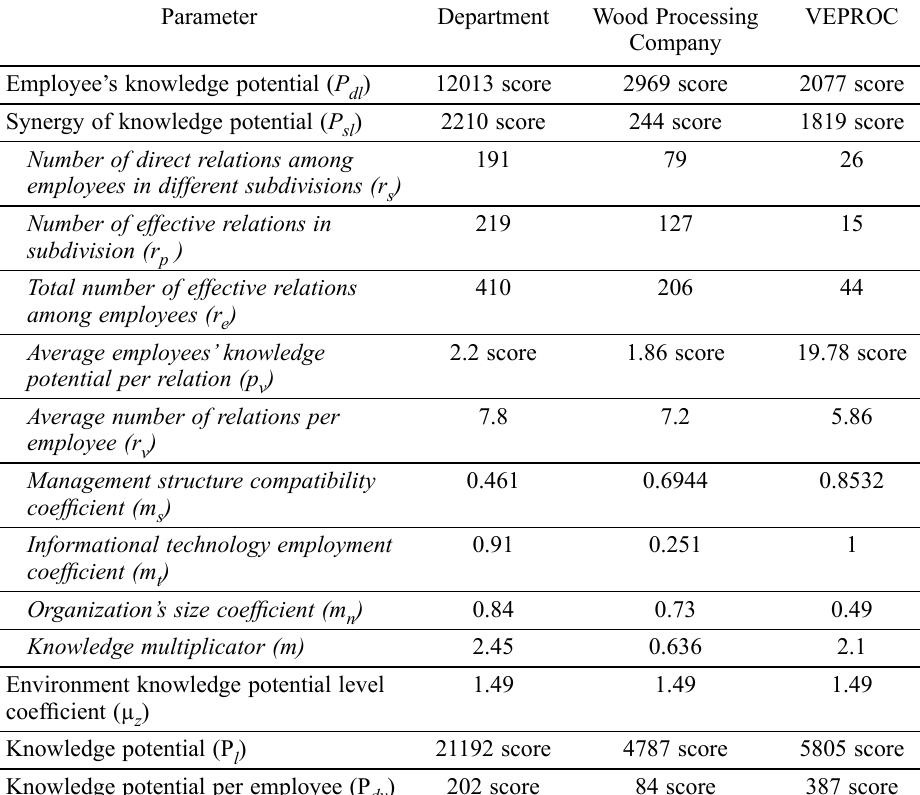
Table 4. Summary of the results of an empirical